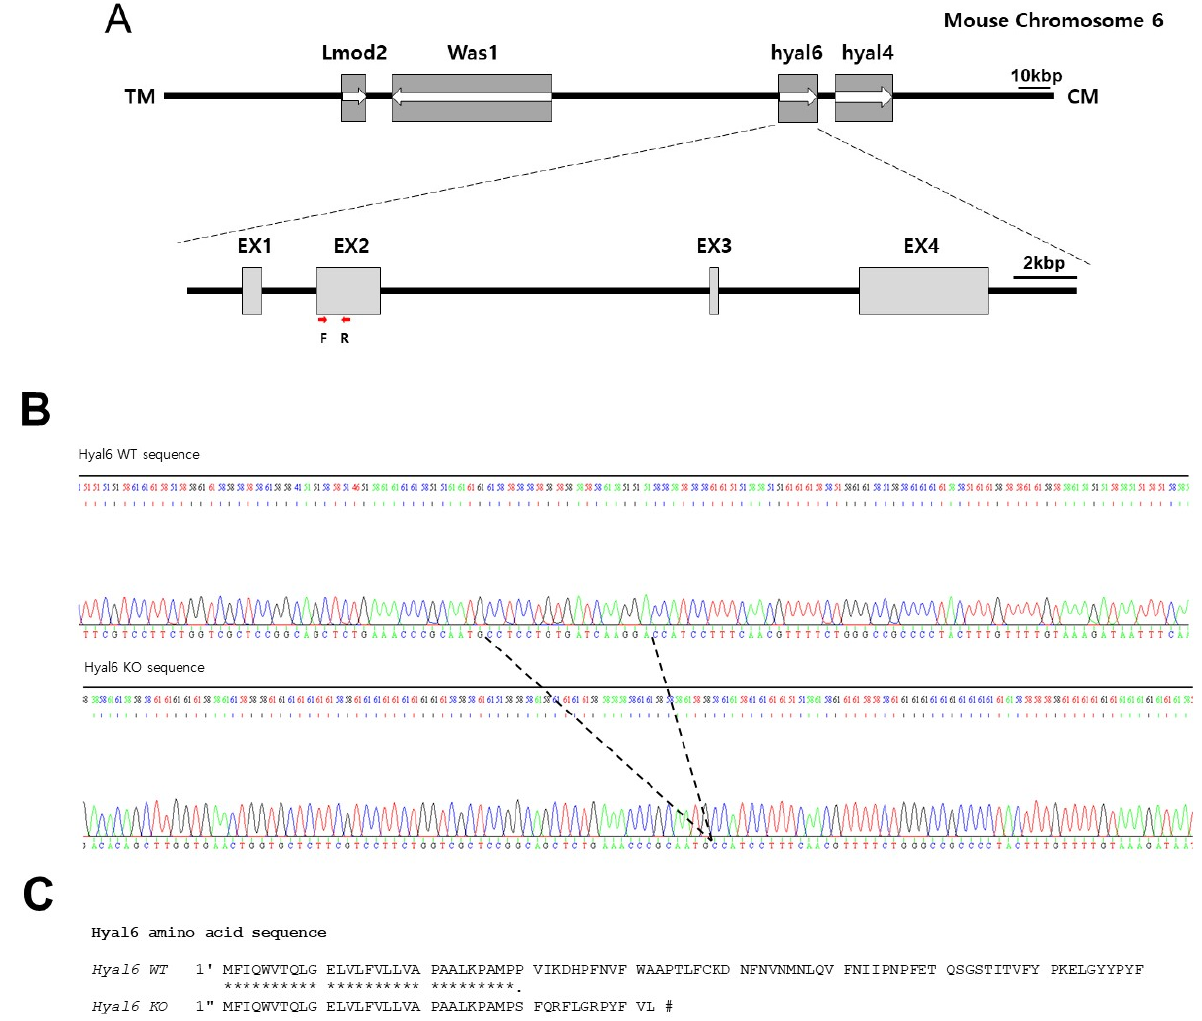
Figure 2. Generating hyaluronidase 6 ( HYAL6 ) knockout mice using clustered regularly interspaced short palindromic repeats (CRISPR)/CRISPR-associated protein 9. ( A ) Mouse HYAL6 contains four exons interrupted by three introns. The ATG translation initiation codon and stop codon are in exons two and four, respectively. F and R indicate primers for genomic PCR analysis. ( B ) Genomic sequence of the CRISPR target site in HYAL6 . Letters inside the dotted lines indicate the target deletion. ( C ) Asterisks (*) indicate amino acids shared between the two sequences, and the hashtag symbol (#) indicates the stop codon.